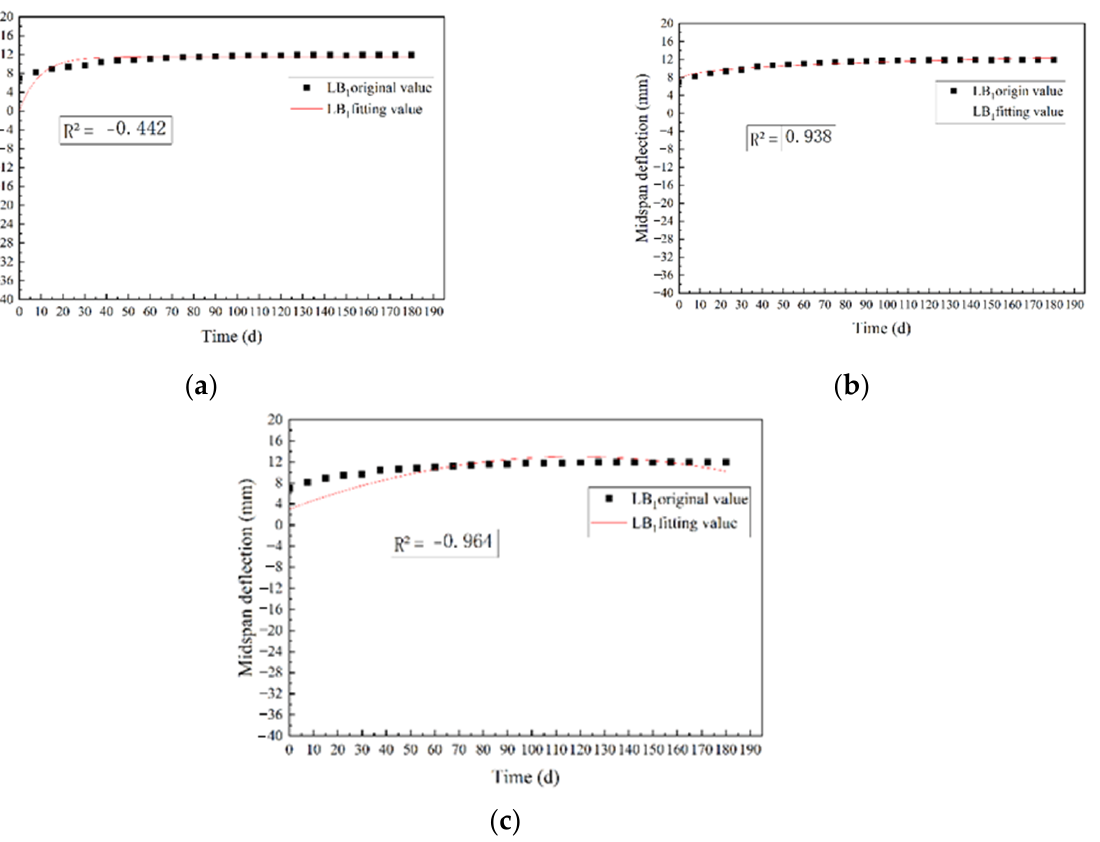
Figure 14. Midspan deflection fitting curve of LB 1 beam under three models: ( a ) exponential equation fitting curve; ( b ) power-law equation fitting curve; ( c ) polynomial equation fitting curve. For the fitted curves, R 2 reflects the fitting degree of the regression equation, and expresses the relationship between the dependent variable and all independent variables, it means the percentage of the dependent variable whose variability can be explained by the regression equation. The fit result is better with the increase in the R 2 value, R 2 is represented by Equation